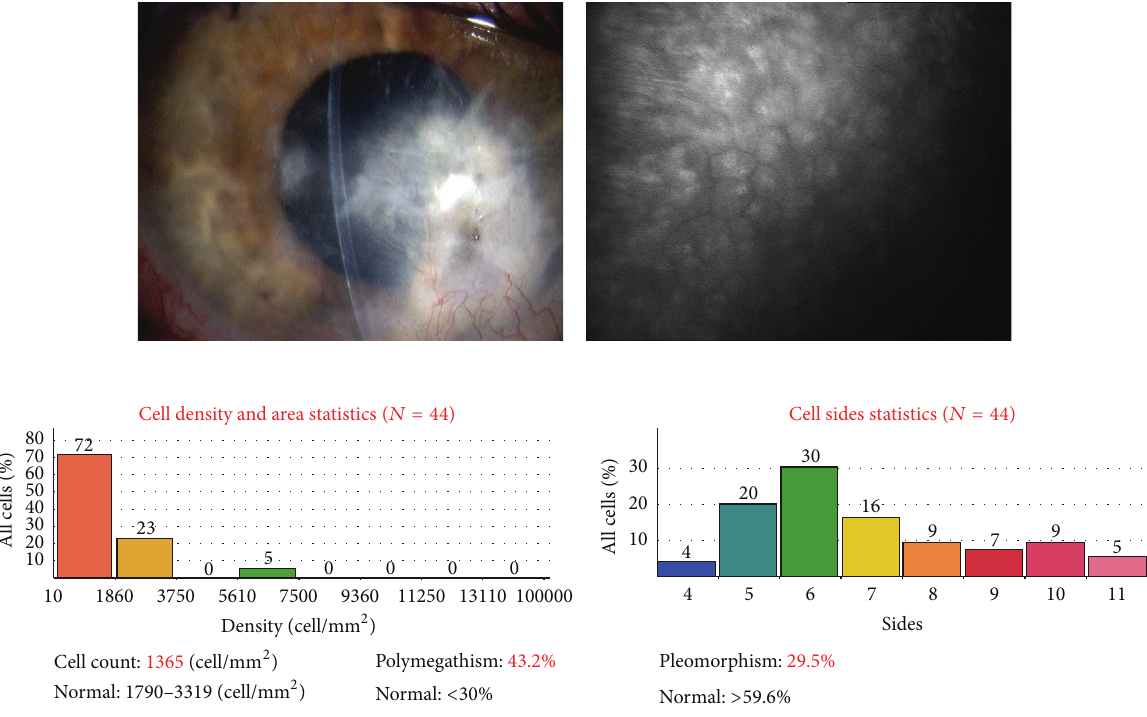
Figure 6: Endothelial cell changes eight months post blast exposure.